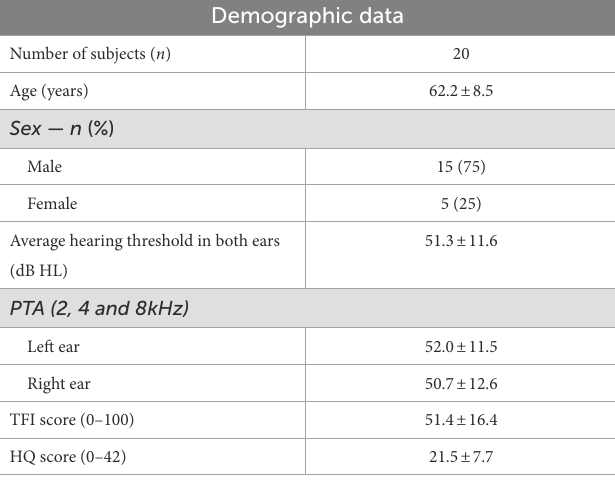
TABLE 1 Demographic characteristics of the